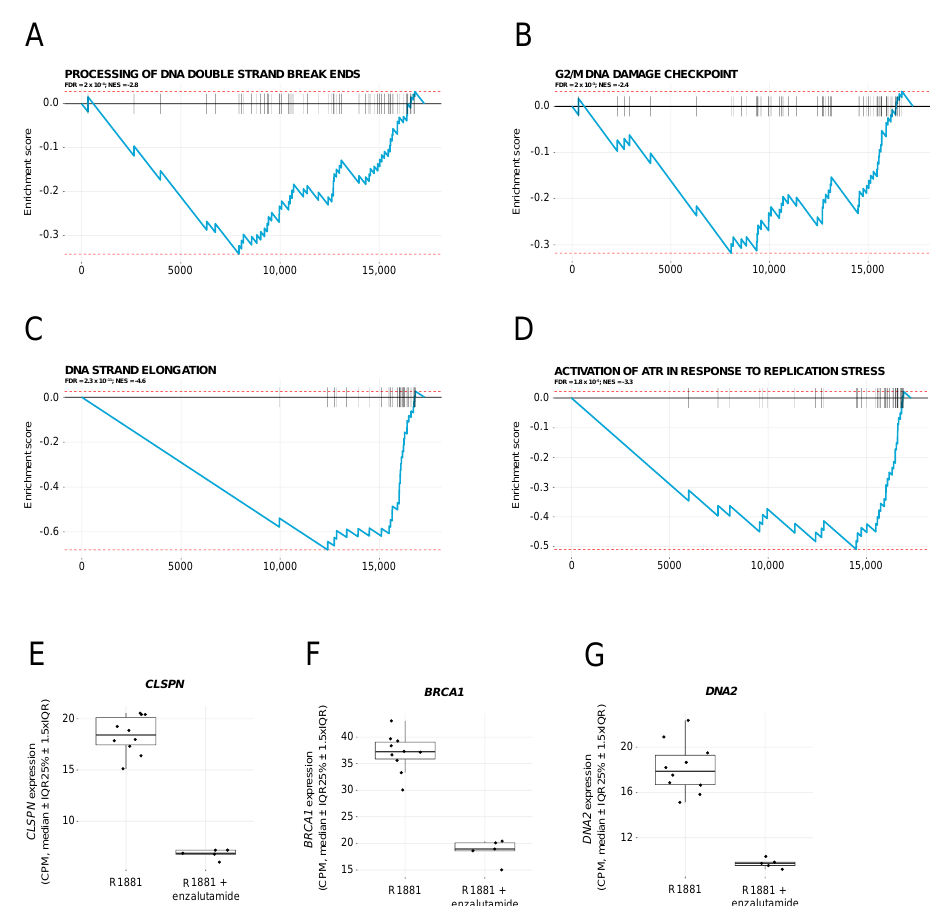
Figure 2. Enzalutamide treatment downregulates pathways involved in DNA damage repair. Gene set enrichment analysis (GSEA) of downregulated pathways related to DNA damage repair in LNCaP cells after treatment with enzalutamide. Enrichment plots for the Reactome pathways: ( A ) “Processing of DNA double-strand breaks ends”, ( B ) “G2/M DNA damage checkpoint”, ( C ) “DNA strand elongation”, and ( D ) “Activation of ATR in response to replication stress”. Effect size and statistical significance are indicated by normalized enrichment scores (NES) and false discovery rate (FDR) for each pathway. Gene expression of ( E ) CLSPN , ( F ) BRCA1 , and ( G ) DNA2 for samples stimulated with R1881 or treated with enzalutamide after R1881 stimulation. Boxplots describe counts per million (CPM, median ± IQR25% ± 1.5xIQR).